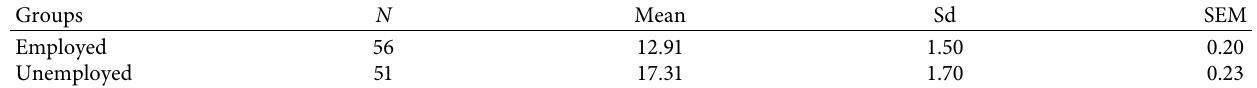
Table 1: Descriptive statistics of anxiety questionnaire of both groups.